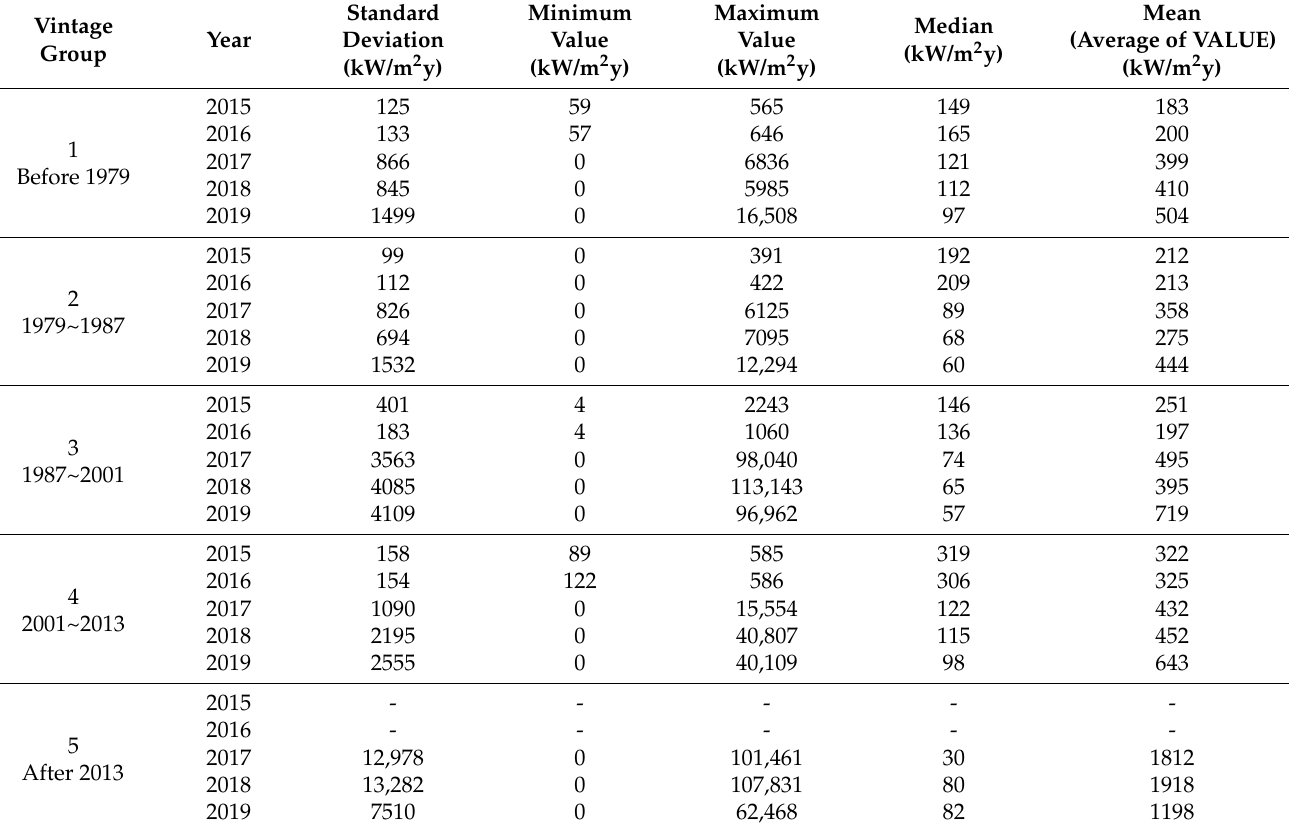
Table 8. Descriptive statistics of the amounts of energy usage by year in each vintage